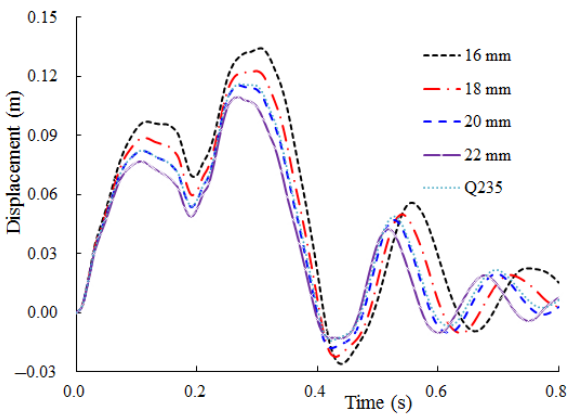
Figure 20. Max displacement time-history of containment.